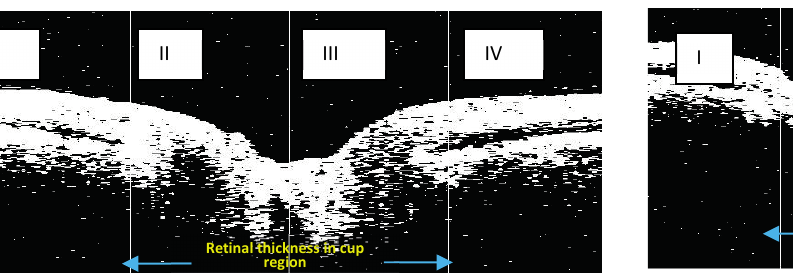
Fig. 9. Retinal area normal image. Fig. 10. Retinal area glaucoma image.